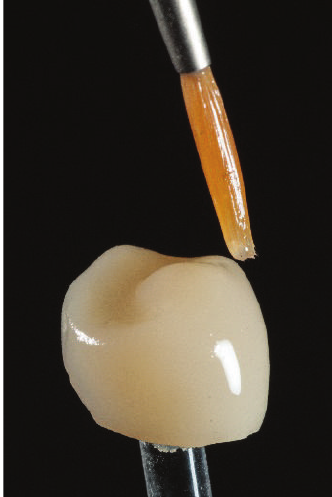
Figure 9: Application of the glazing material.